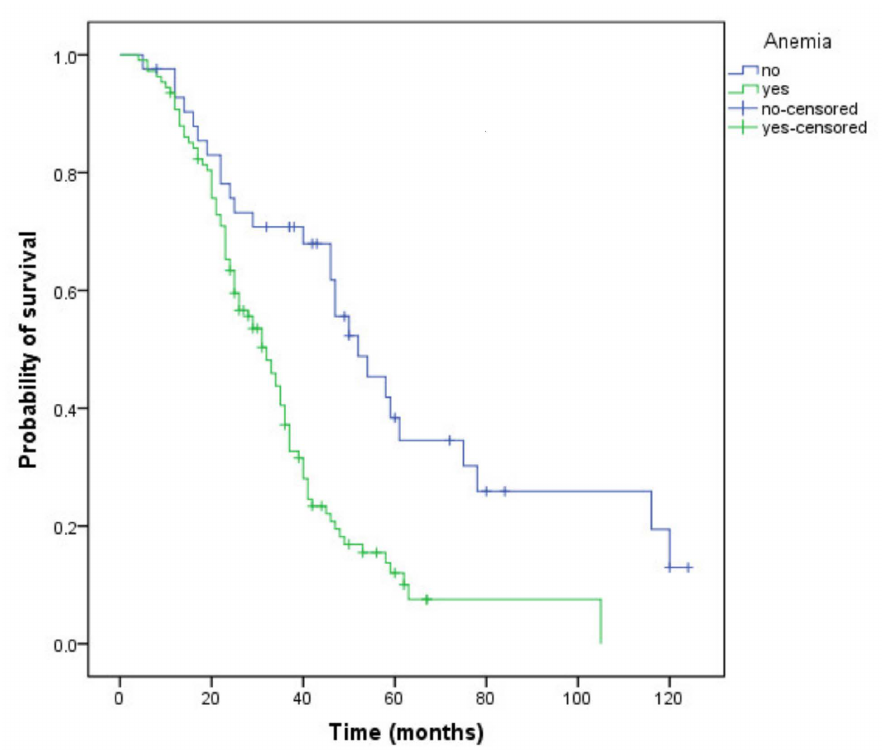
Figure 3. Kaplan–Meier curve of overall survival for patients who have or have not developed anemia during treatment (OS, 32 versus 52 months, p < 0.001).